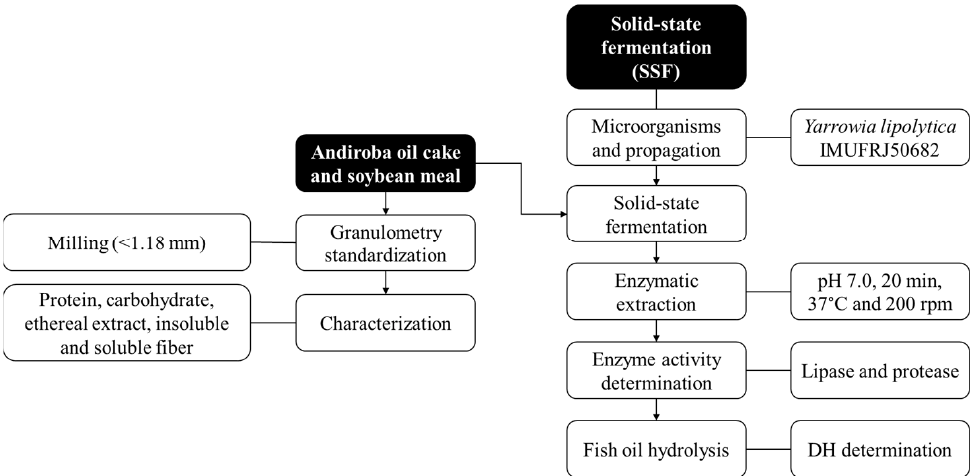
Figure 1. Process of lipase production using the combination of andiroba oil cake and soybean meal as solid matrix substrates from Yarrowia lipolytica IMUFRJ50682 in SSF.